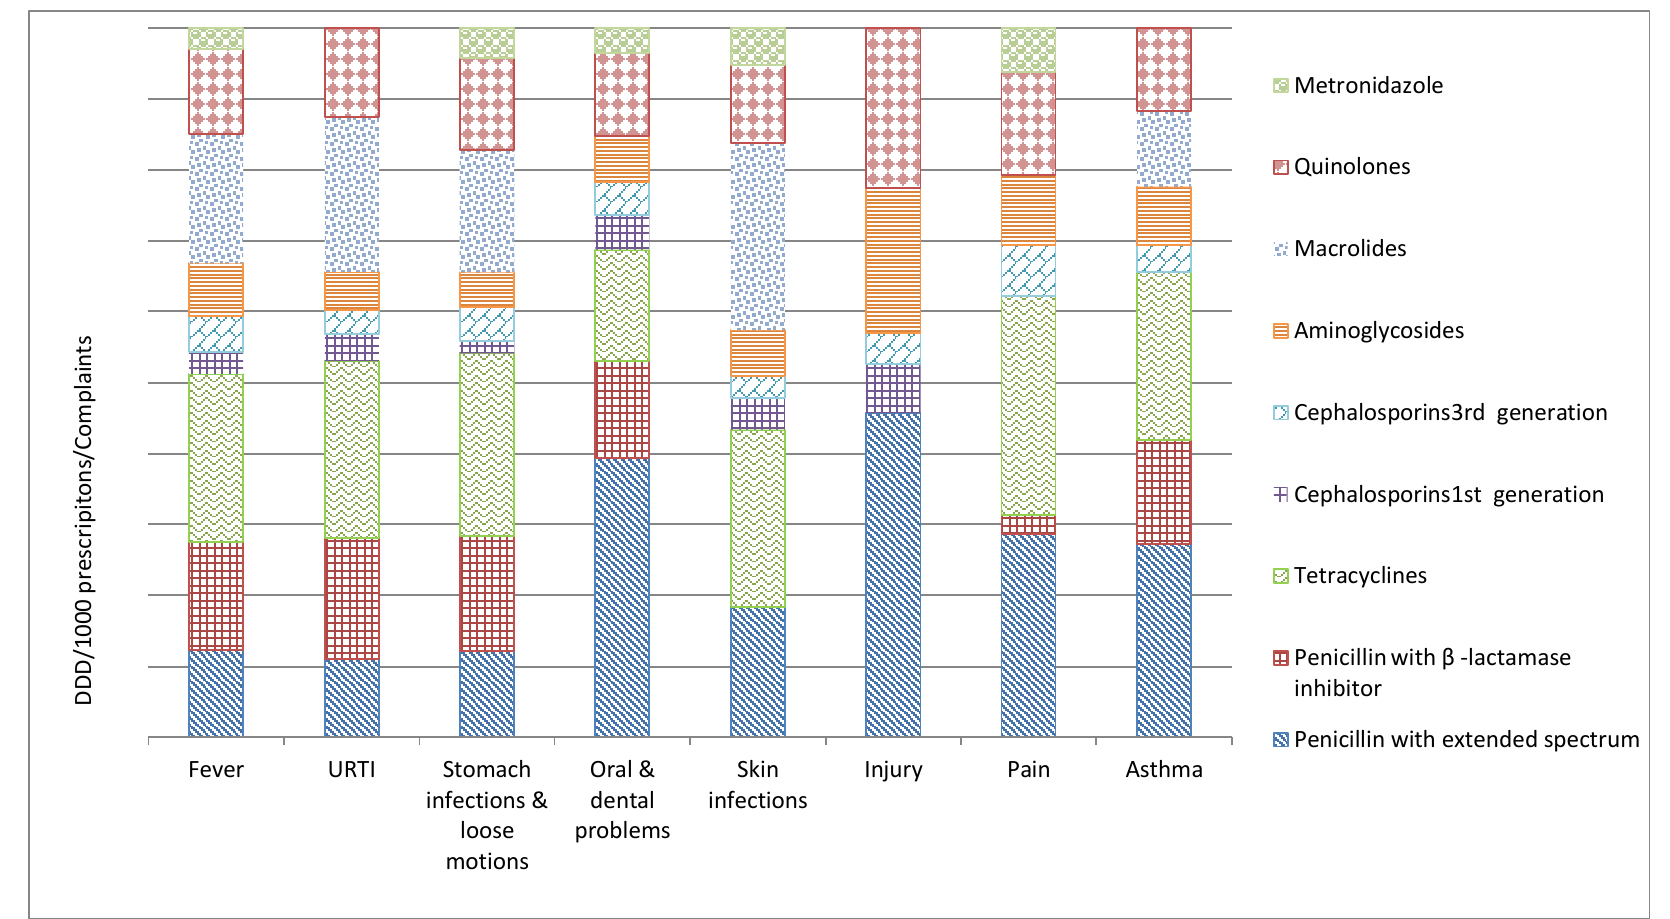
Figure 2. Relative distribution of defined daily doses/1000 prescriptions/presenting complaints (DDD/TPP) in rural Ujjain, India. X axis represents the defined daily doses/1000 prescriptions/presenting complaints (DDD/TPP); Y axis represents the complaints (URTI — Upper respiratory tract infection, Pain — Unspecified pain).